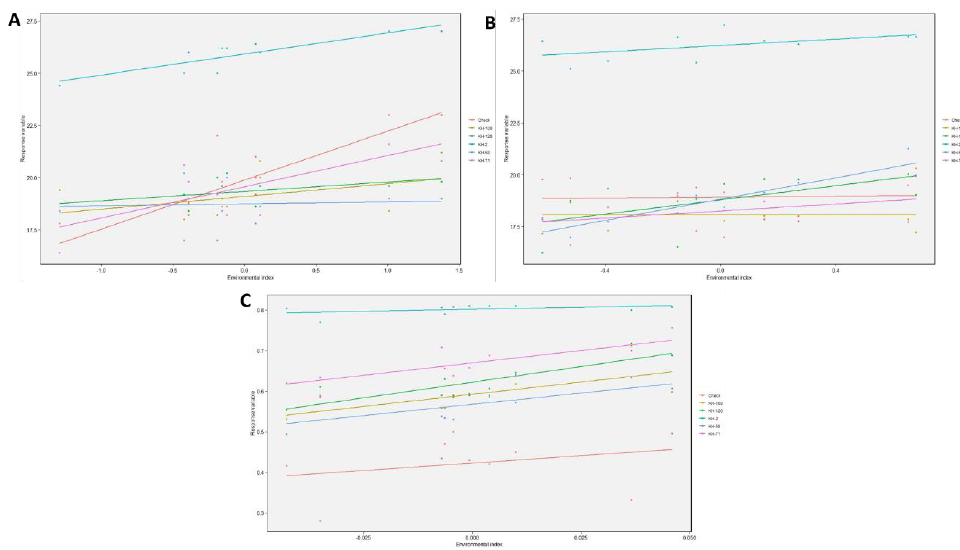
Figure 1. Nominal yield plot for the yield traits ( A ) DRR ( B ) FRY ( C ) EO yield . 3.4. AMMI ANOVA for the Agronomical Traits for Six High-Yielding Accessions